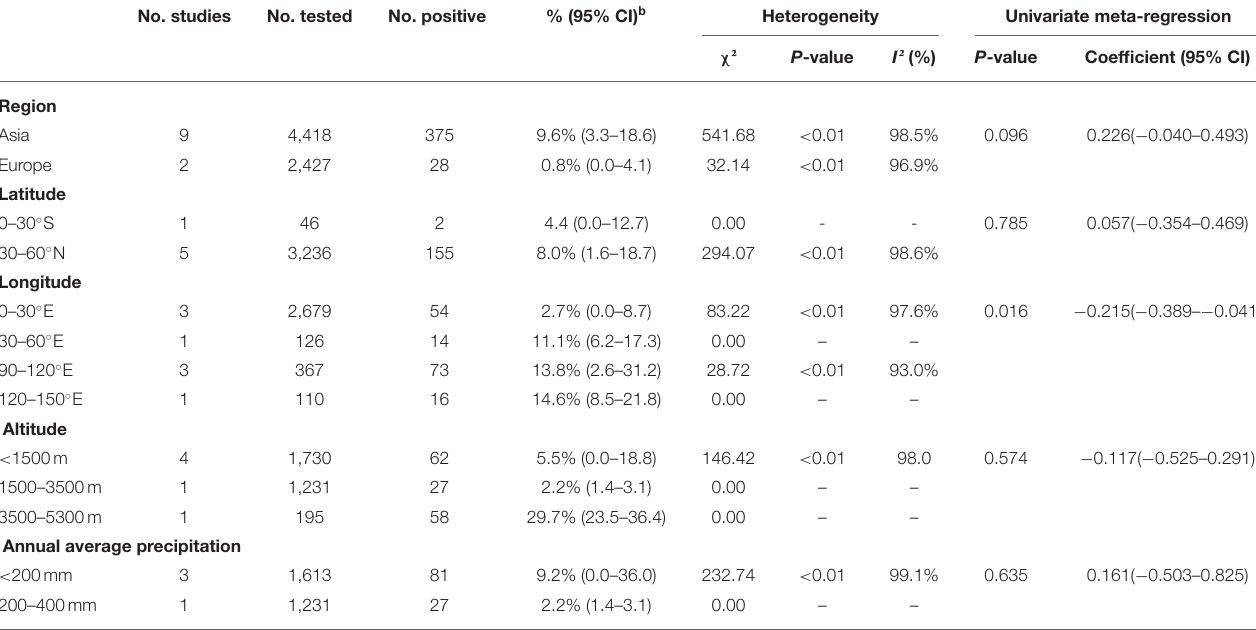
TABLE 7 | Sub-group analysis of the prevalence of BVDV based on geographical factors (Molecular methods). No.